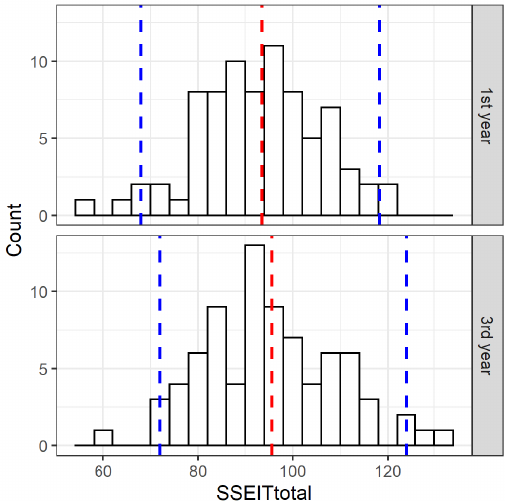
Figure 2. Distribution of SSEIT scores by year of study with mean value (blue) and confidence interval (red) in the first year and third year of study.